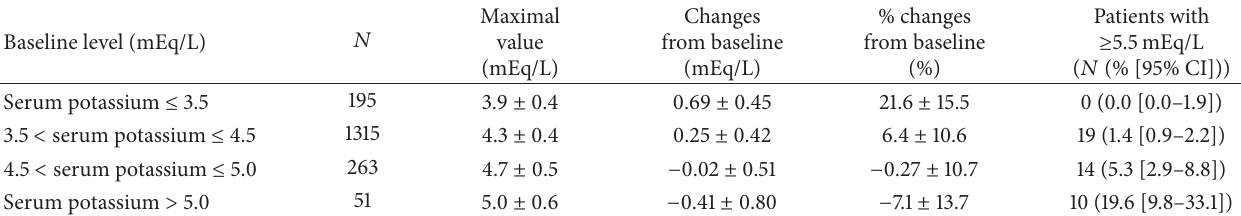
Table 4: Serum potassium levels during eplerenone treatment relative to baseline levels.